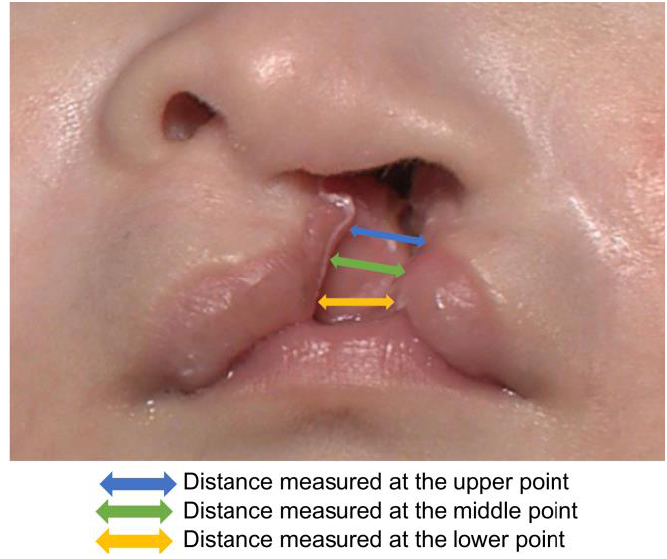
Figure 3. Width of the cleft lip measured on 3D images. Blue line, distance measured at the upper point; green line, distance measured at the middle point; yellow line, distance measured at the lower point.